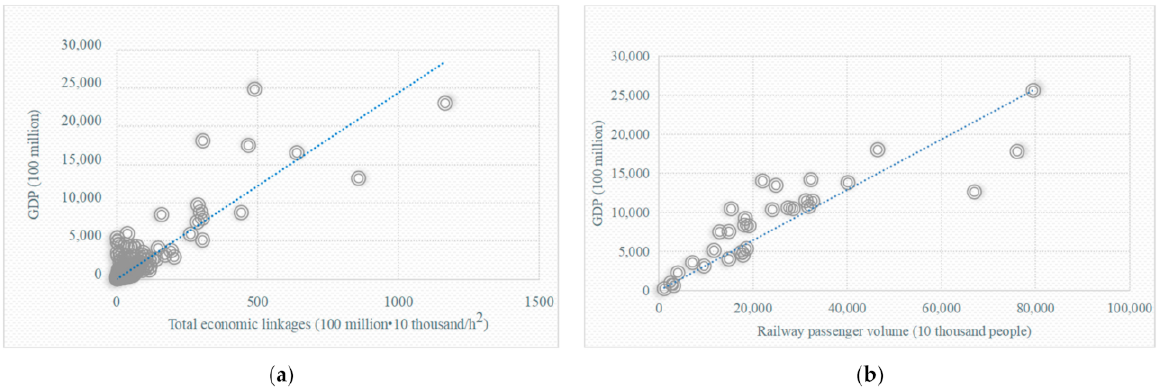
Figure 11. Characteristics of spatial connection pattern and sustainable development. ( a ) The correla- tion between total economic connection and GDP; ( b ) The correlation between railway passenger volumes and